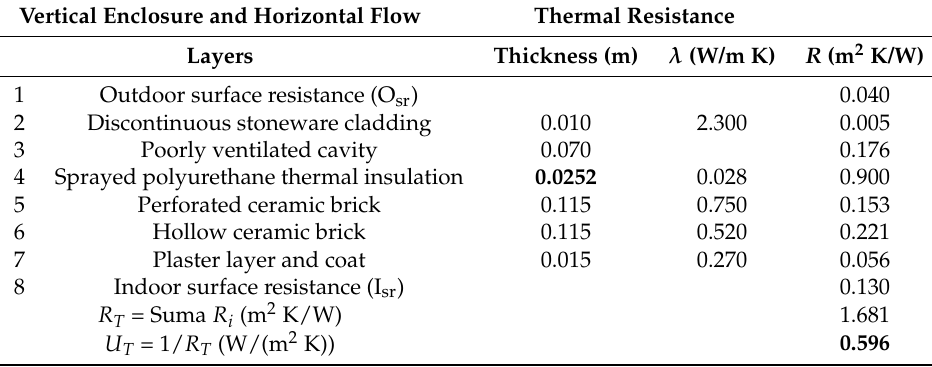
Table 10. Value of the actual thickness of the thermal insulation of polyurethane foam, according to λ obtained by the Mathis TCi equipment, and U-value according to C1